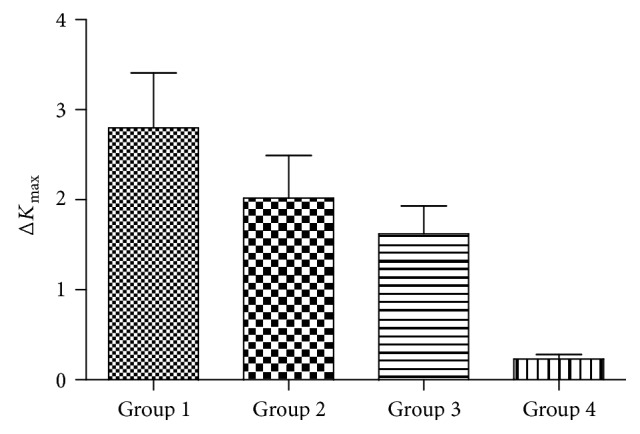
Comparison of ΔKmax between four groups after six months of treatment.